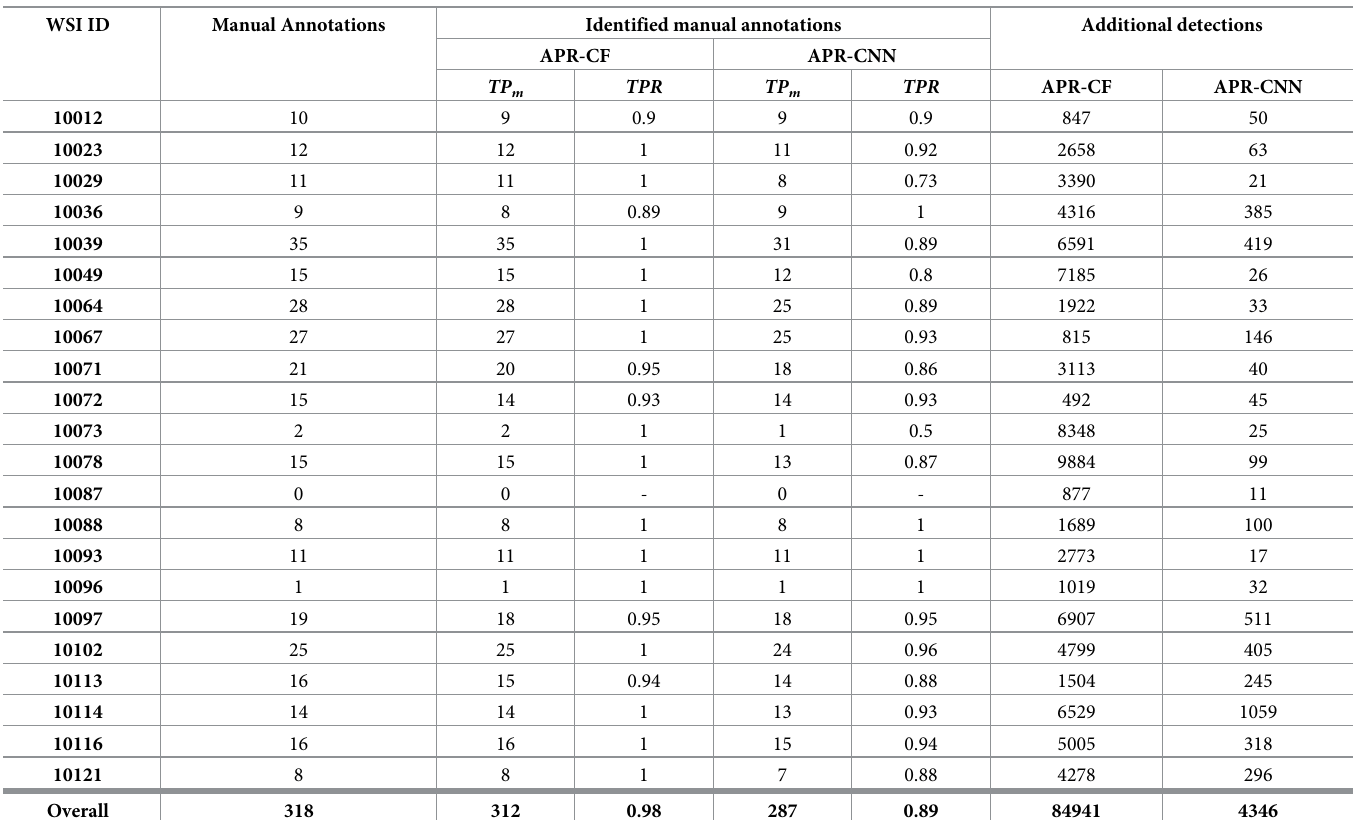
Table 3. Results with respect to the expert manual annotations. WSI ID Manual